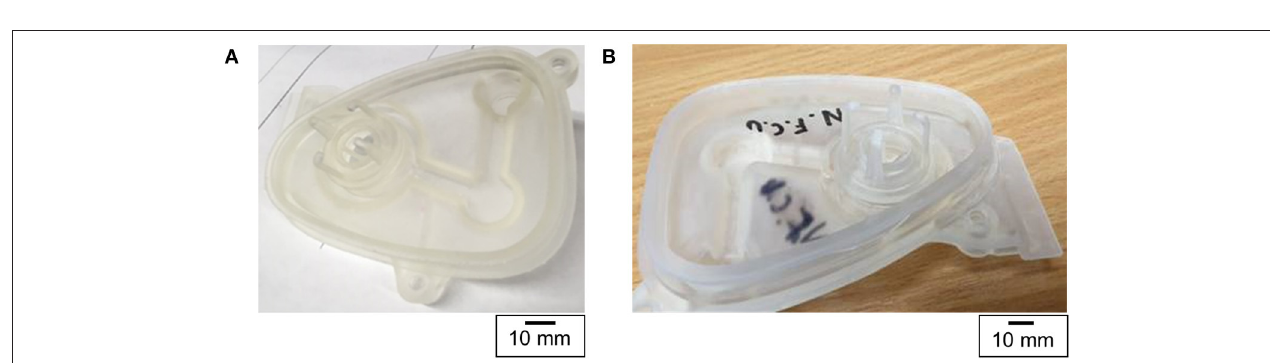
FIGURE 4 | 3D printing preview: the manifold cover in blue and the support structures in grey [ (A) front and (B) back views].